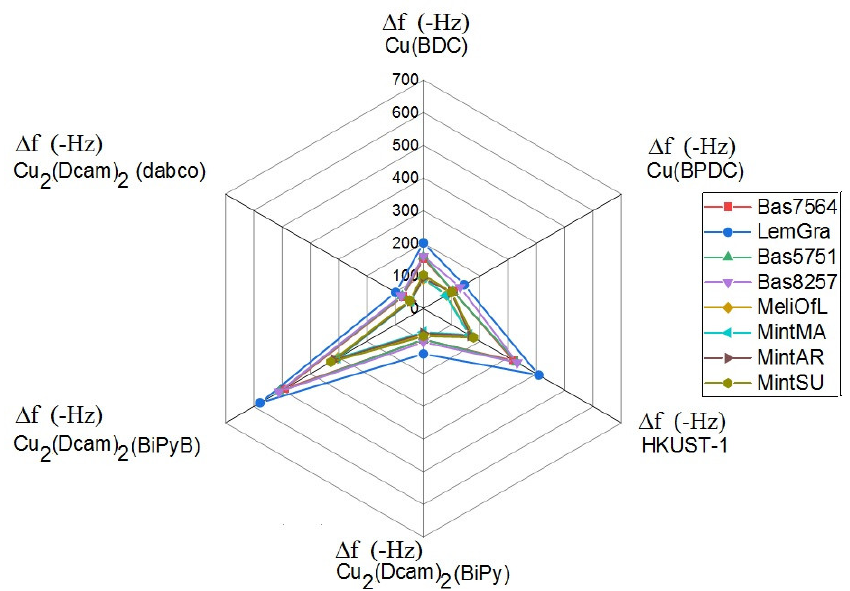
Figure 5. Radar plot of the maximum frequency shift responses of the sensor array. Table 2. The maximum frequency shift response values of the sensor arrays shown in the radar plot in Figure 5.